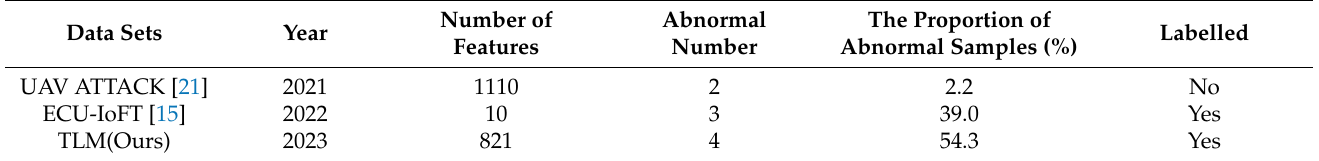
Table 9. Comparison of different UAV anomaly detection data sets.